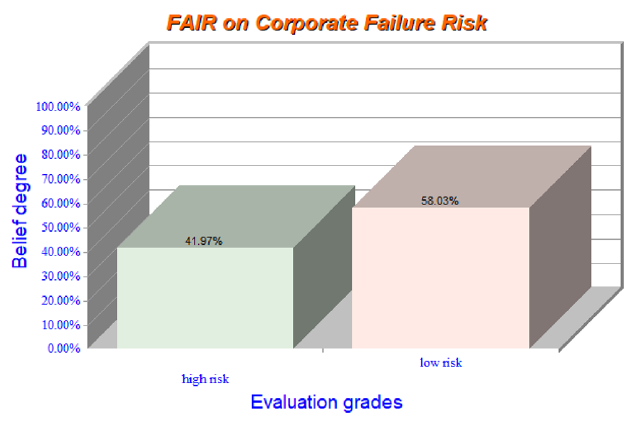
Figure 6. The assessment of a company.